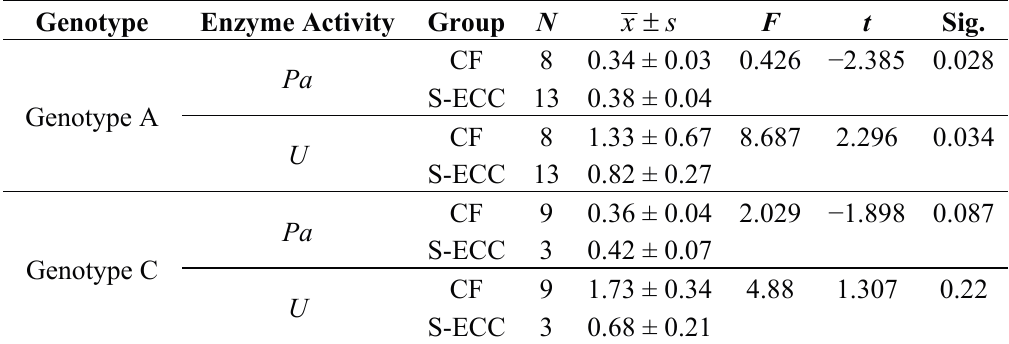
Table 4. Comparison of Saps activity in different genotype